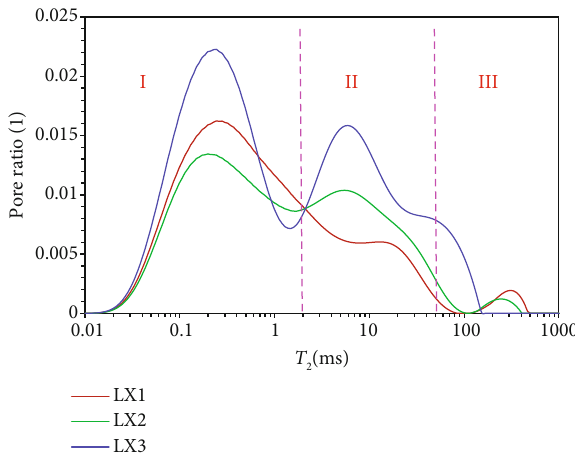
Figure 10: Pore size ratio distribution of the three tight gas sandstone